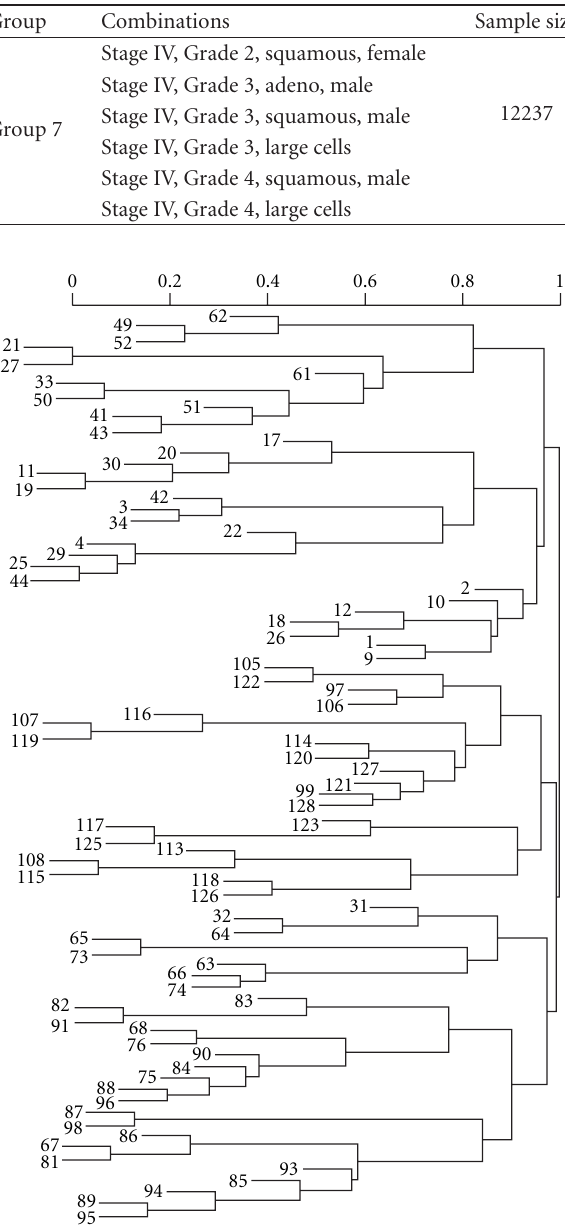
Figure 1: Dendrogram from clustering of lung cancer